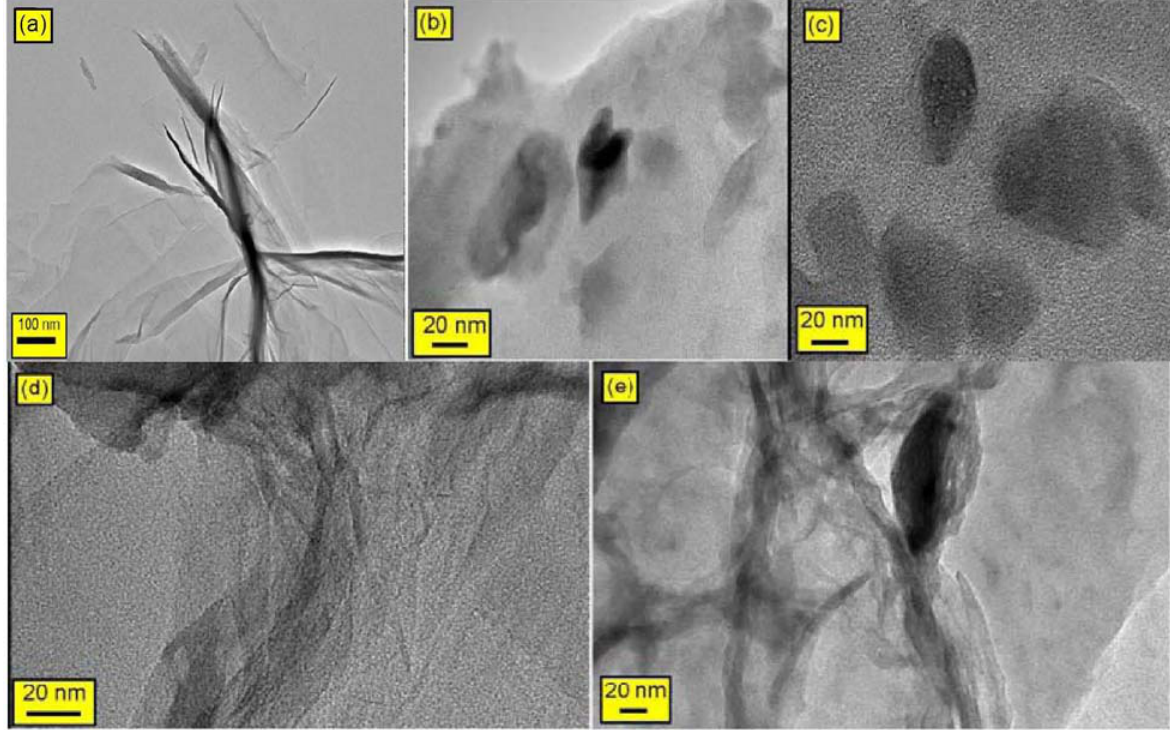
Figure 6. The TEM micrographs of ( a ) RGO; ( b ) neat PMMA; ( c )